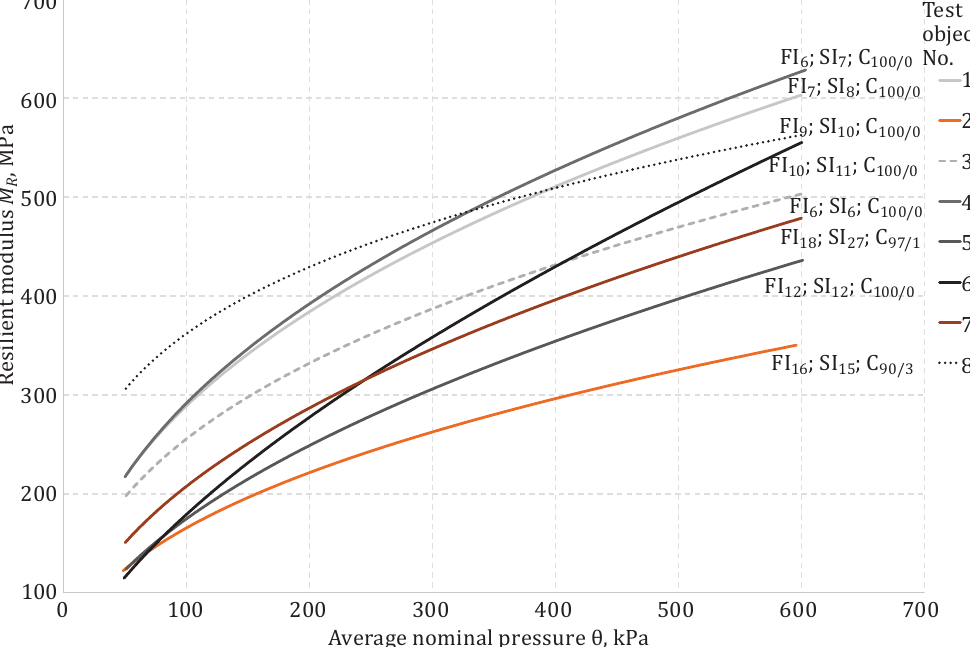
Figure 4. Effect of the aggregate flakiness, shape indices and relative amount of crushed and broken aggregate particles on resilient modulus within different average nominal